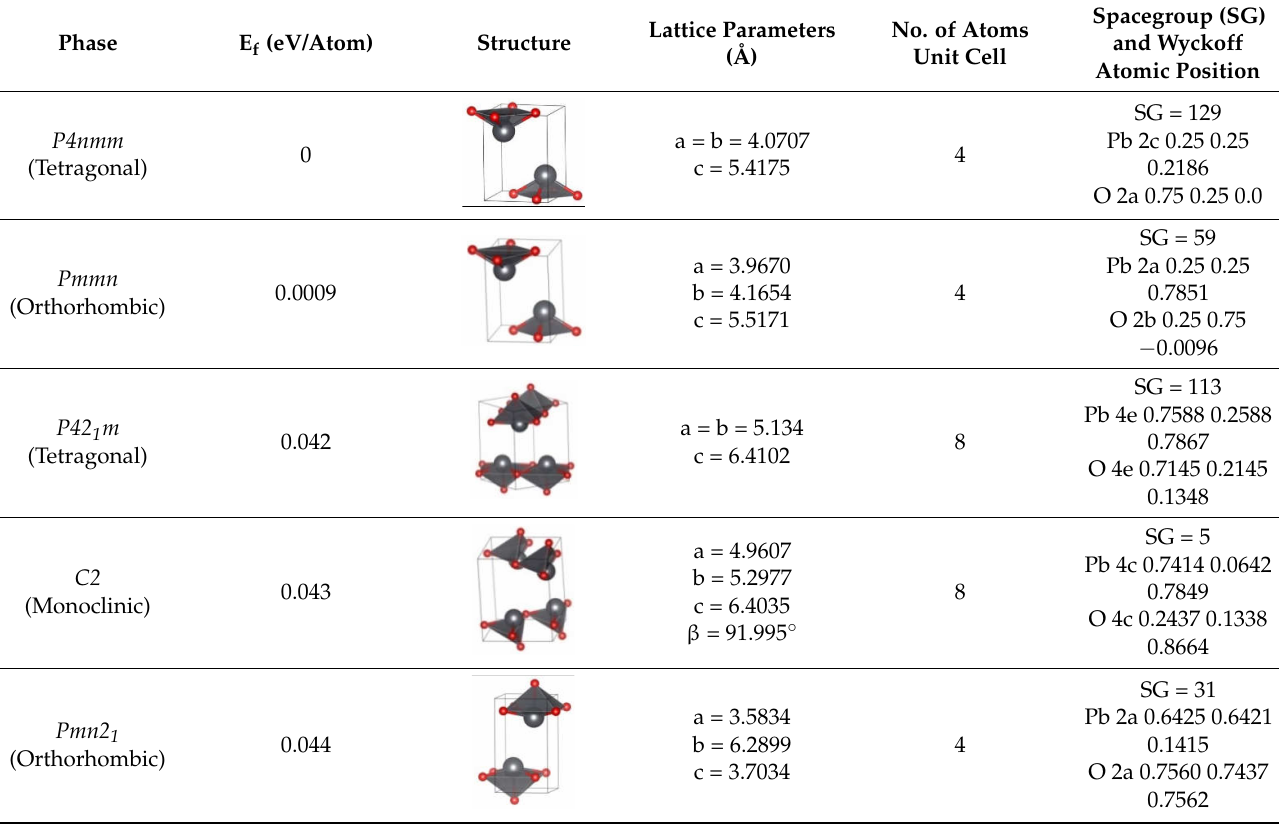
Table 2. Low enthalpy PbO phases predicted by GA at P = 0 GPa and their structural parameters (Pb: gray and O: red).